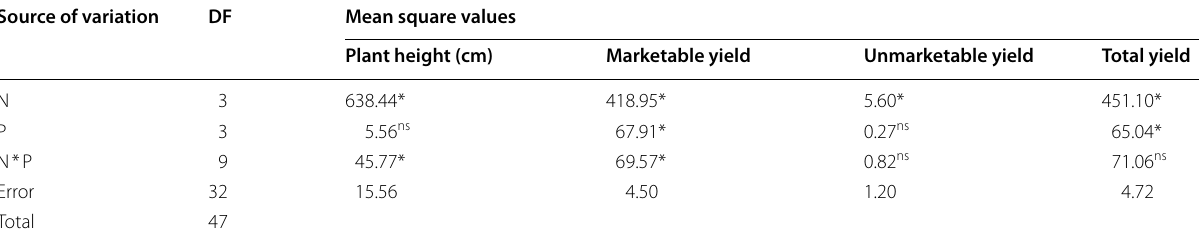
ns non-significant, * and ** significant and highly significant respectively Table 3 ANOVA for the effect of N and P fertilizers on the plant height (cm), marketable yield, unmarketable yield and total yield (t ha − 1 ) of potato 2015 Source of